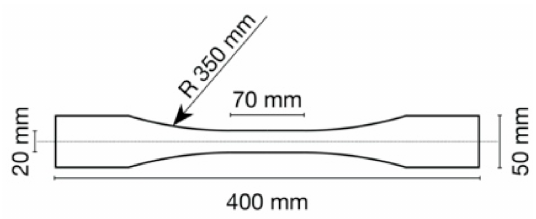
Figure 2. Tensile strength specimen